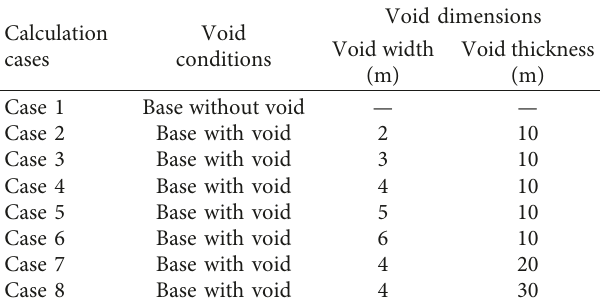
Figure 5: Schematic diagram for under-track base void of the tunnel. Table 3: Description of calculation cases of void.